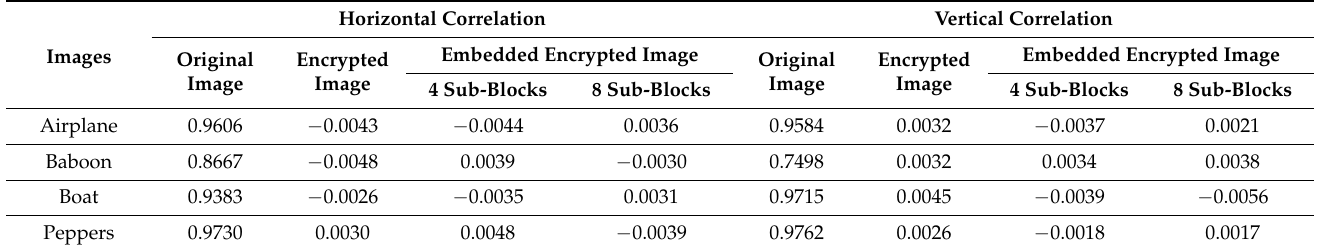
Table 9. Correlation distribution of images in different directions when the pixel block size is 32 × 32.